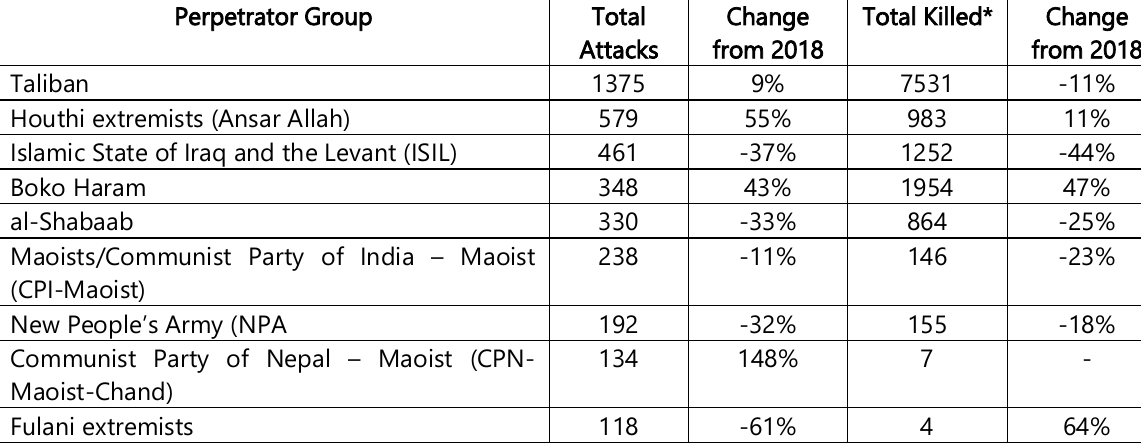
Table 2: Perpetrator Groups Responsible for more than 100 Terrorist Attacks, 2019 (Source: